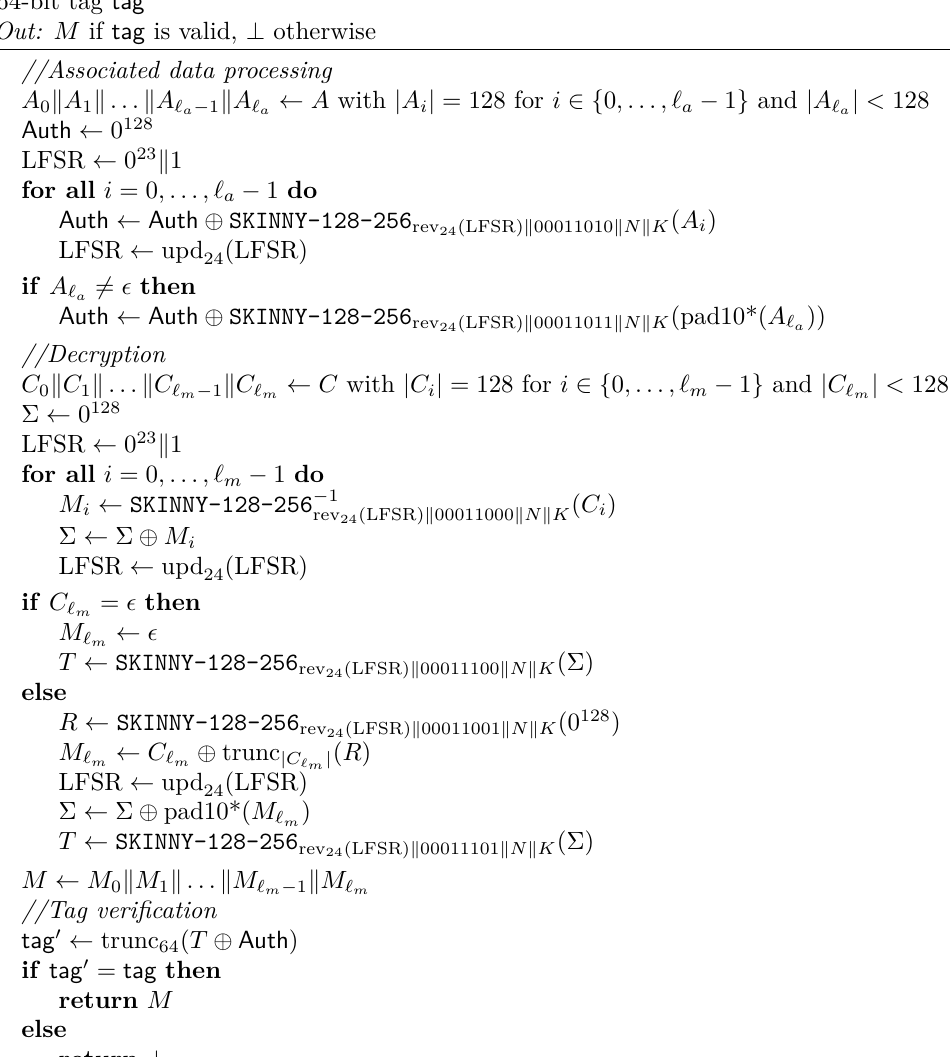
Algorithm 14 The decryption algorithm SKINNY - AEAD - M6 - Dec ( K, N, A, C, tag